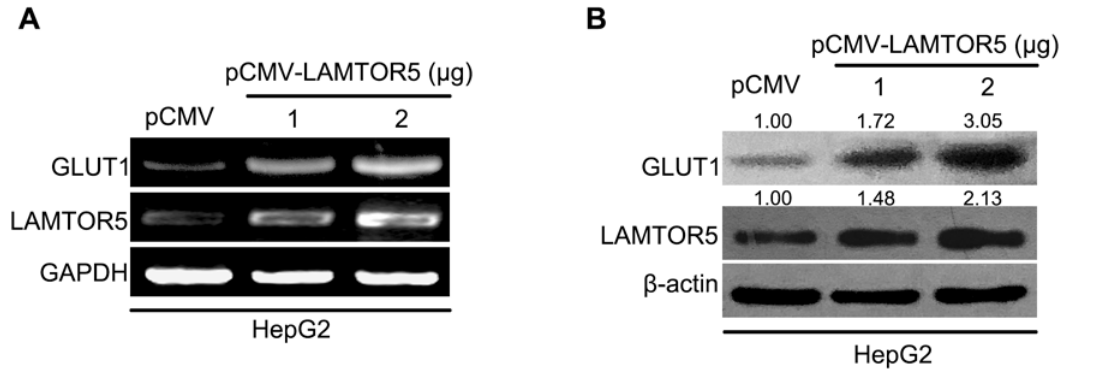
Figure 1: Oncogenic LAMTOR5 is able to upregulate the expression of GLUT1 in hepatoma cells. (A, B) Level of mRNA and protein of GLUT1 in hepatoma HepG2 cells after LAMTOR5 was overexpressed was analyzed through RT-PCR and Western blotting. ImageQuant 5.2 software (GE Healthcare, UK) was used to quantify the bands of GLUT1 and LAMTOR5 relative to β-actin.